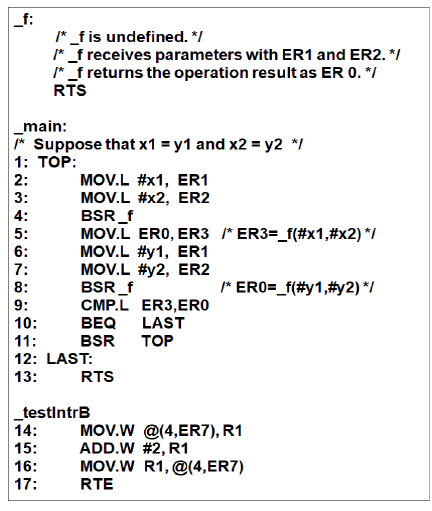
Figure 15. Program